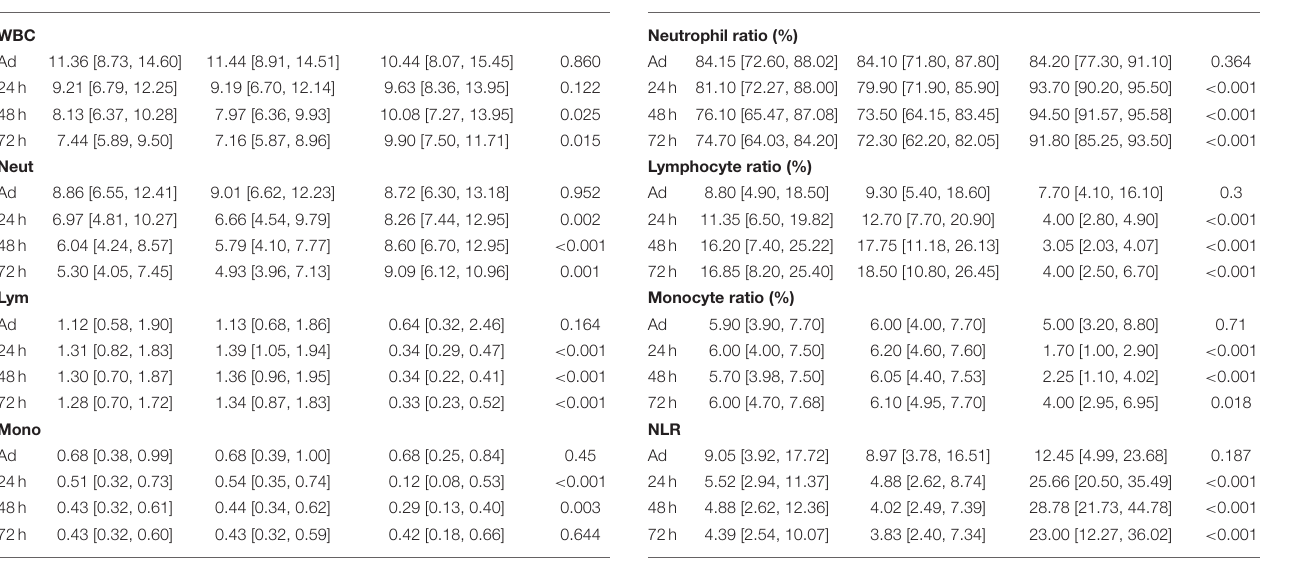
TABLE 1 | The dynamic change of immune cell counts in patients with exertional heatstroke (EHS). Overall ( N = 189) Survivor ( N = 166) Non-survivor ( N = 23) P -value